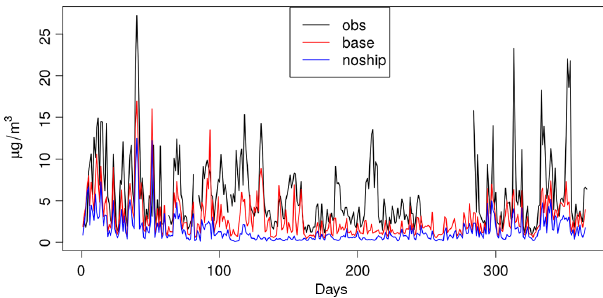
Figure 7. NO 2 concentration time series at